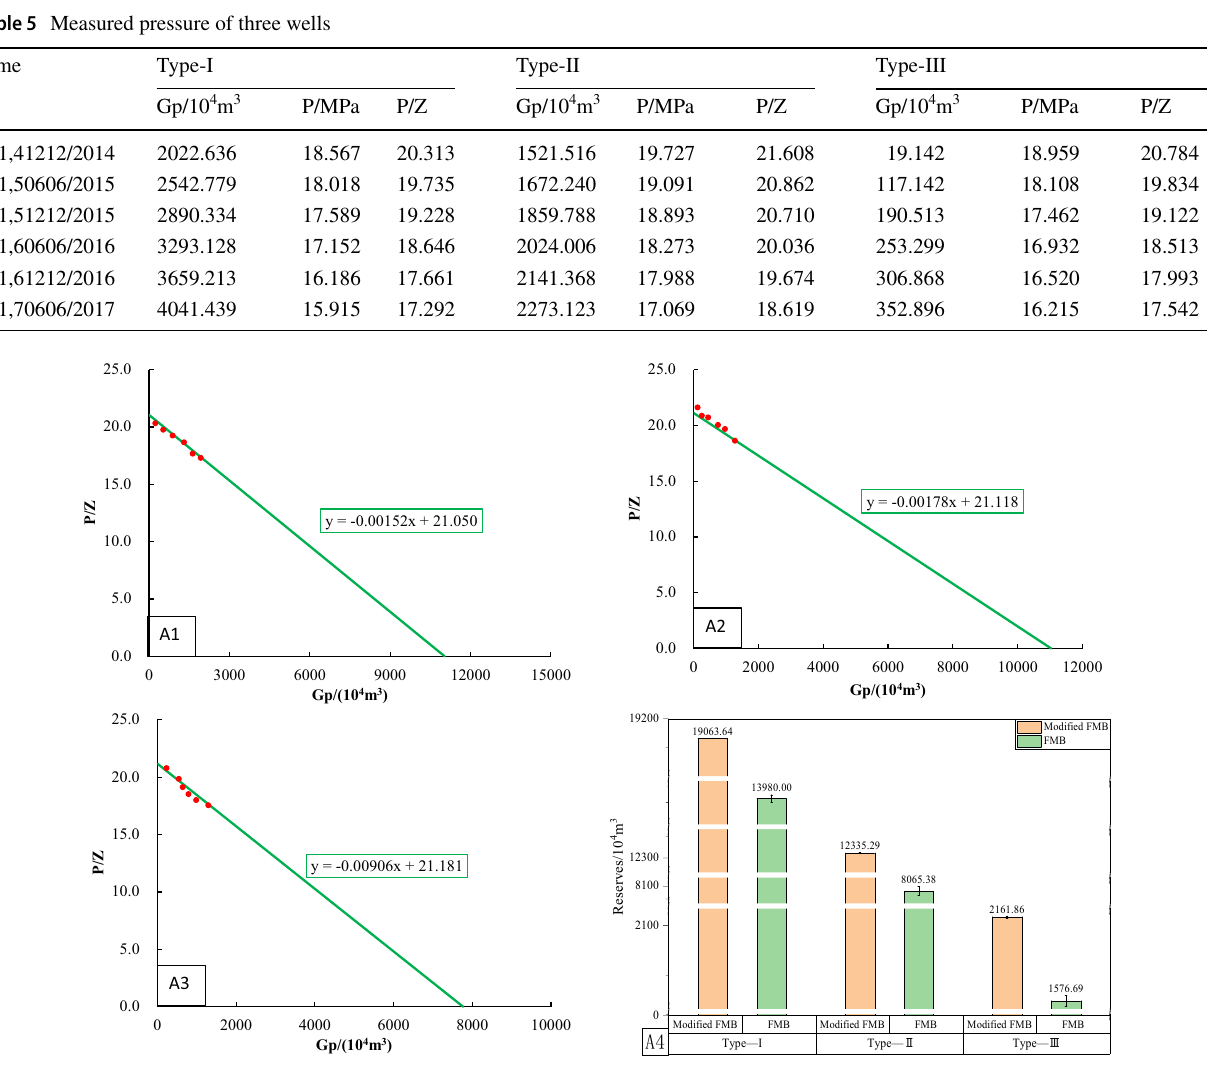
Fig. 16 Calculation of dynamic reserves by MB Table 6 Calculation results of FMB method and modified FMB